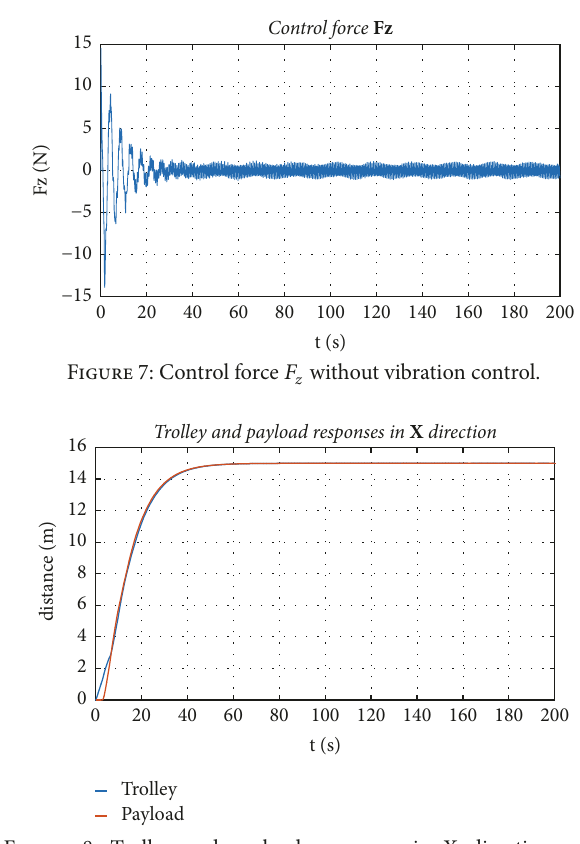
Figure 8: Trolley and payload responses in X direction with vibration